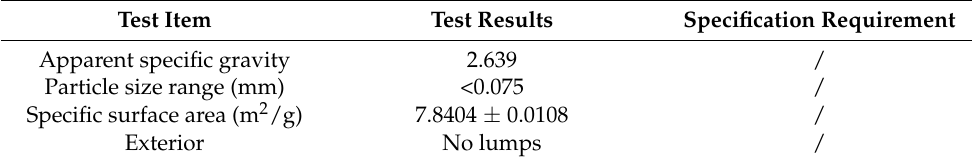
Table 4. Physical properties of the limestone mineral